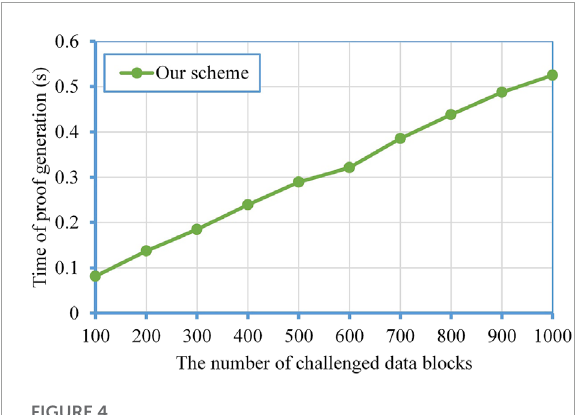
FIGURE 4 The computation overhead of proof generation.